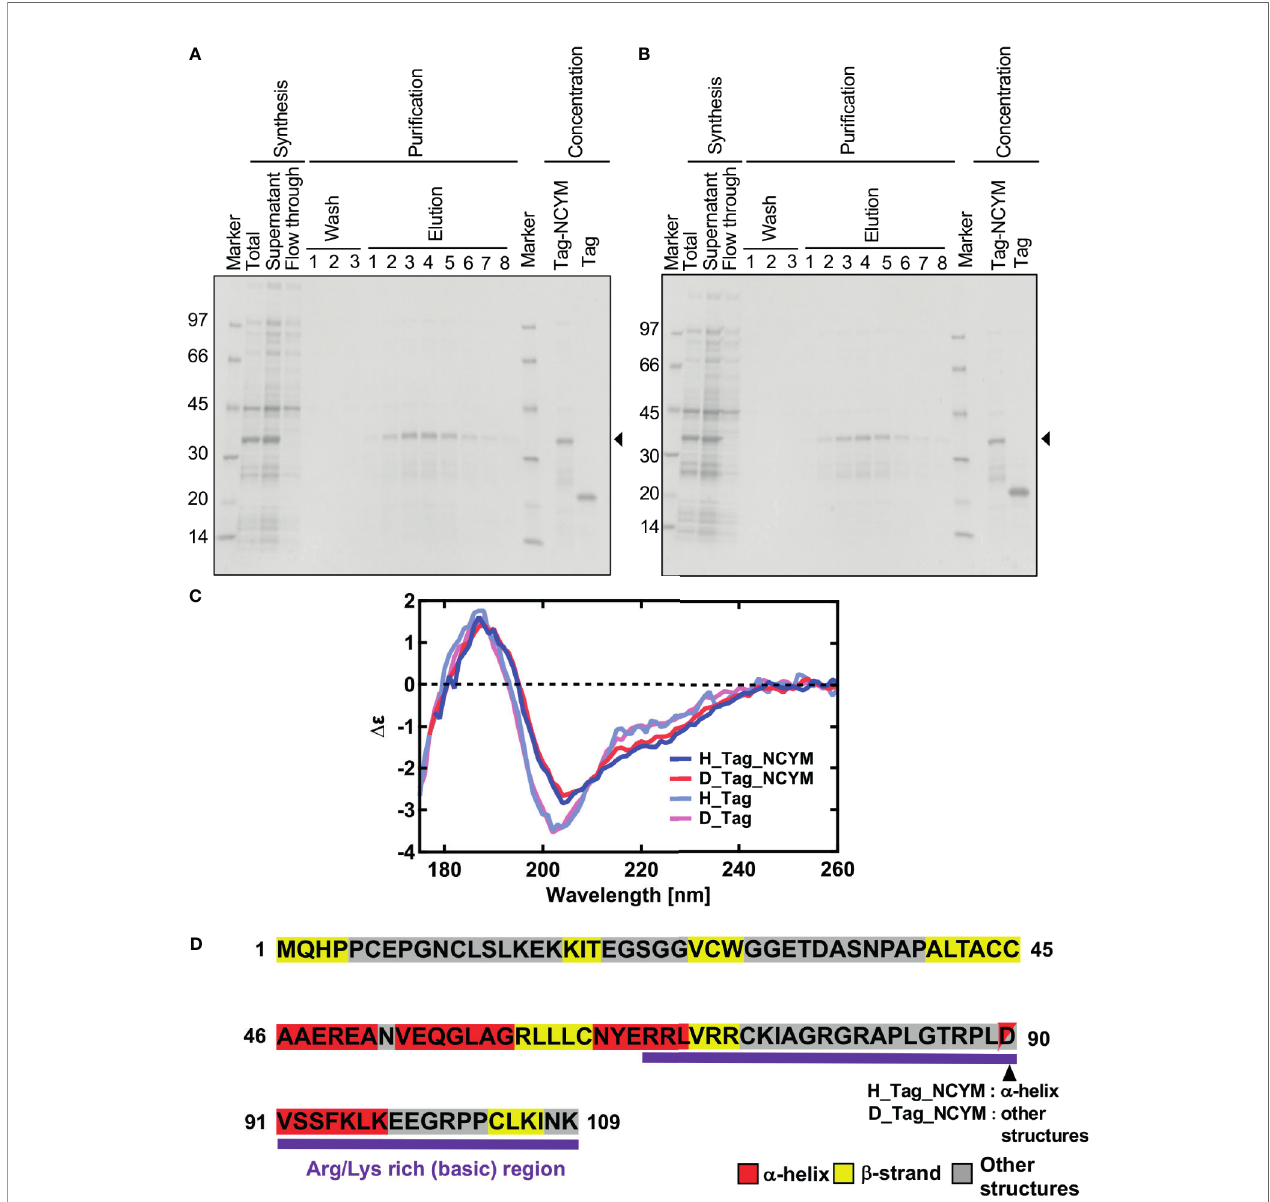
FIGURE 1 | Vacuum-ultraviolet circular dichroism (VUVCD) analyses revealed the secondary structure of NCYM. (A) NCYM with SUMO tag (arrow) and the isolated SUMO tag were synthesized and puri fi ed using an in vitro cell-free system. (B) Perdeuterated NCYM with SUMO tag (arrow) and the isolated SUMO tag were synthesized and puri fi ed using an in vitro cell-free system. (C) VUVCD spectra for hydrogenated SUMO-tagged NCYM (H_Tag_NCYM), perdeuterated SUMO-tagged NCYM (D_Tag_NCYM), hydrogenated SUMO tag (H_Tag), and perdeuterated SUMO tag (D_Tag). (D) Secondary structure of NCYM predicted using the neural network. Secondary structures are highlighted in red, yellow, and gray for a -helix, b -strand, and other structures, respectively. Arg/Lys-rich (basic) region is highlighted in